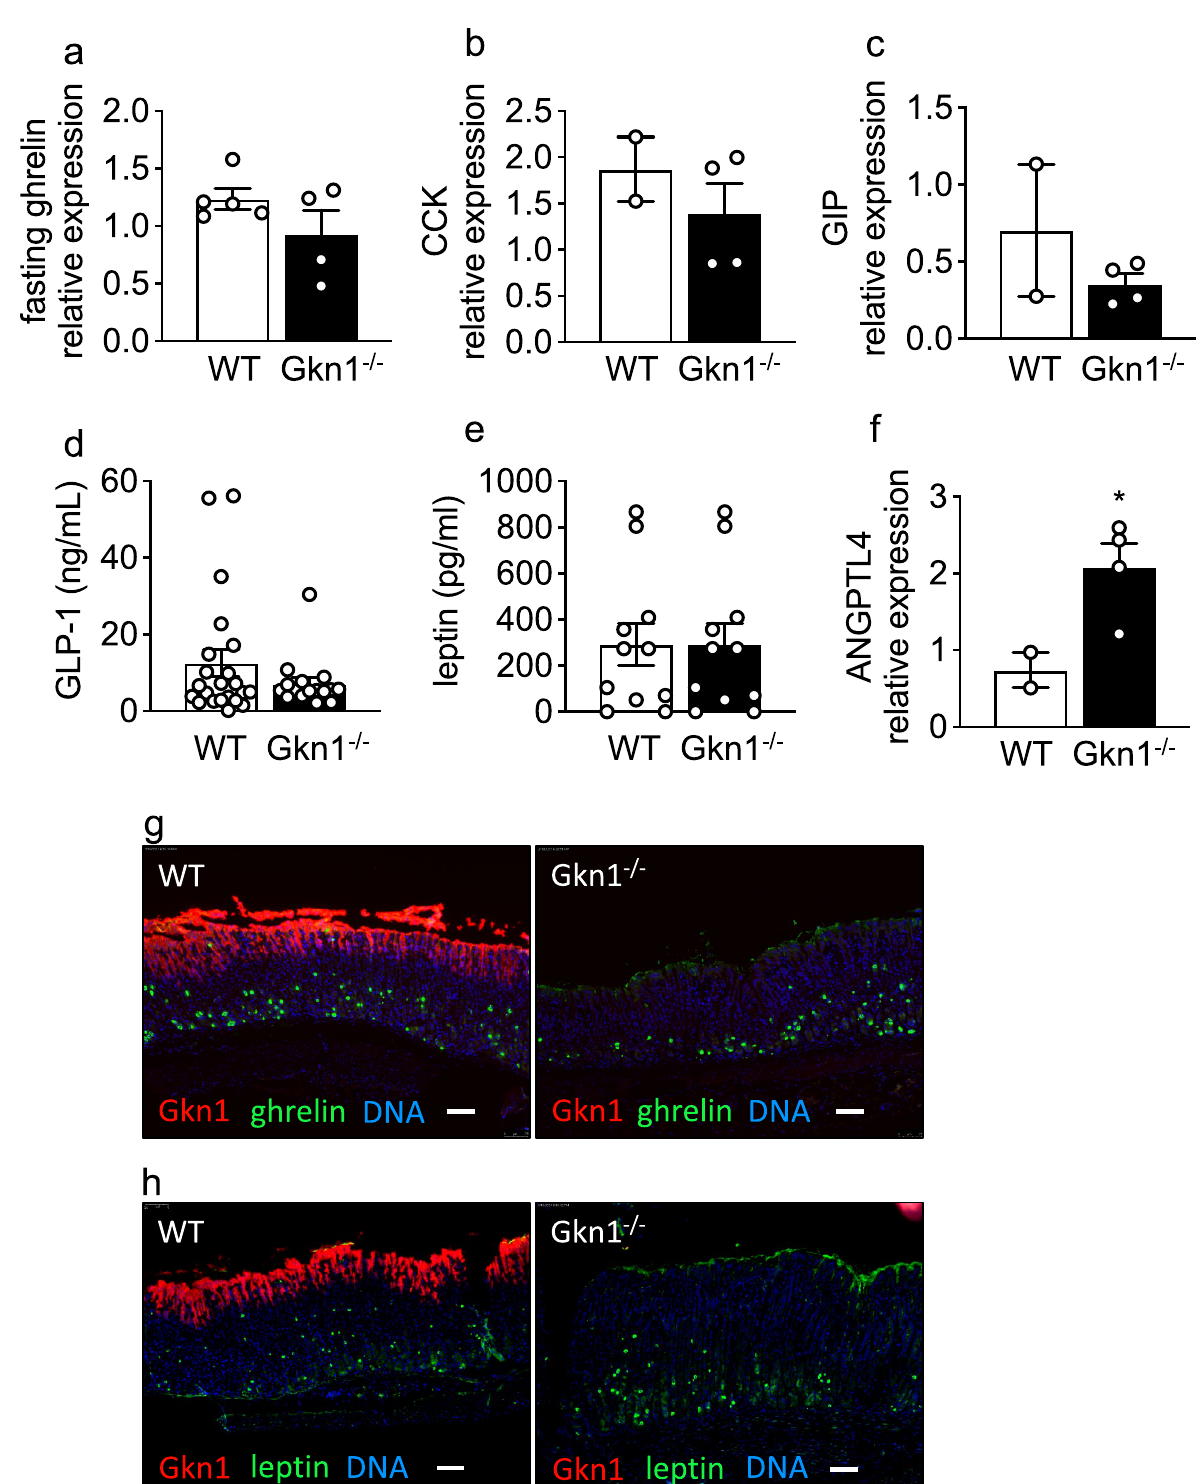
Figure 2. GKN1 regulates Angptl4 expression in the intestine. WT and GKN1 −/− mice were assessed for gastric mucosal expression of ( a ) ghrelin and intestinal gene expression of ( b ) CCK, ( c ) GIP mRNA measured by qPCR (n = 2–4). Serum levels of ( d ) GLP-1 or ( e ) leptin by ELISA (n > 4). ( f ) Intestinal expression of ANGPTL4 mRNA measured using qPCR (n = 2–4). The qPCR data was normalized to GAPDH. Immunolocalization of Gkn1 in the gastric mucosa compared to ( g ) ghrelin or ( h ) leptin in WT vs. Gkn1 −/− mice (scale bar is 75 μM). * p <